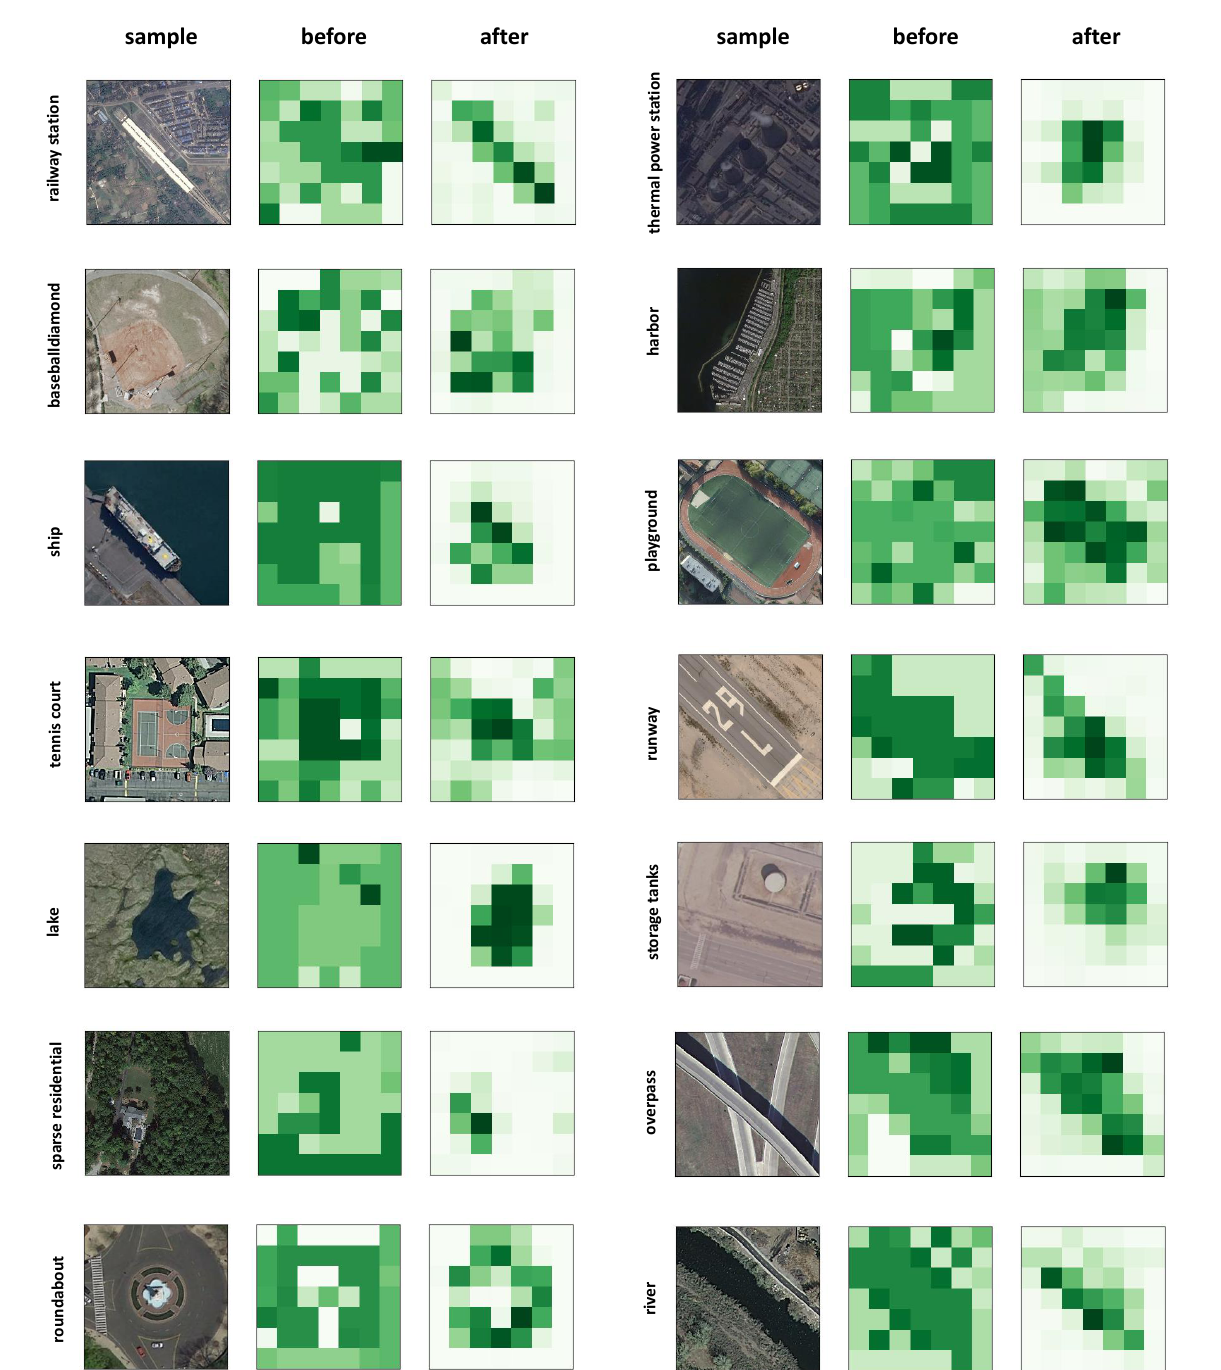
Figure 17. Visualization of feature maps of example vectors before and after MIL